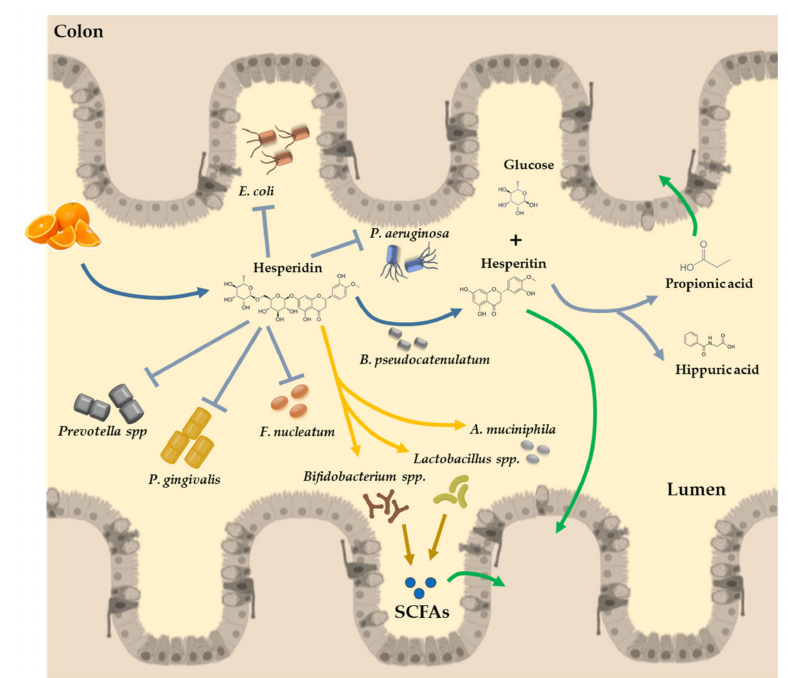
Figure 3. Illustrative diagram of hesperidin absorption in the colon. The flavones present in oranges reach the colon almost unchanged in their structure. In the lumen of the colon, hesperidin is converted to its active form by the α -rhamnosidase activity of the microbiota ( Bifidobacterium pseudocatenulatum ), releasing the rutinose moiety and hesperetin for further absorption by the colonocytes. In the colon, hesperidin promotes the growth of some beneficial bacteria species, with a key role in the SCFA production ( Bifidobacterium spp., Lactobacillus spp., or Akkermansia muciniphila ). SCFAs are absorbed with healthy effects in the permeability of the gut barrier and in distal organs and tissues. Moreover, hesperidin has other beneficial effects by inhibiting the proliferation of detrimental bacteria, such as Escherichia coli , Pseudomonas aeruginosa , Prevotella spp., Porphyromonas gingivalis , and Fusobacterium nucleatum , among others. SCFAs: short chain fatty